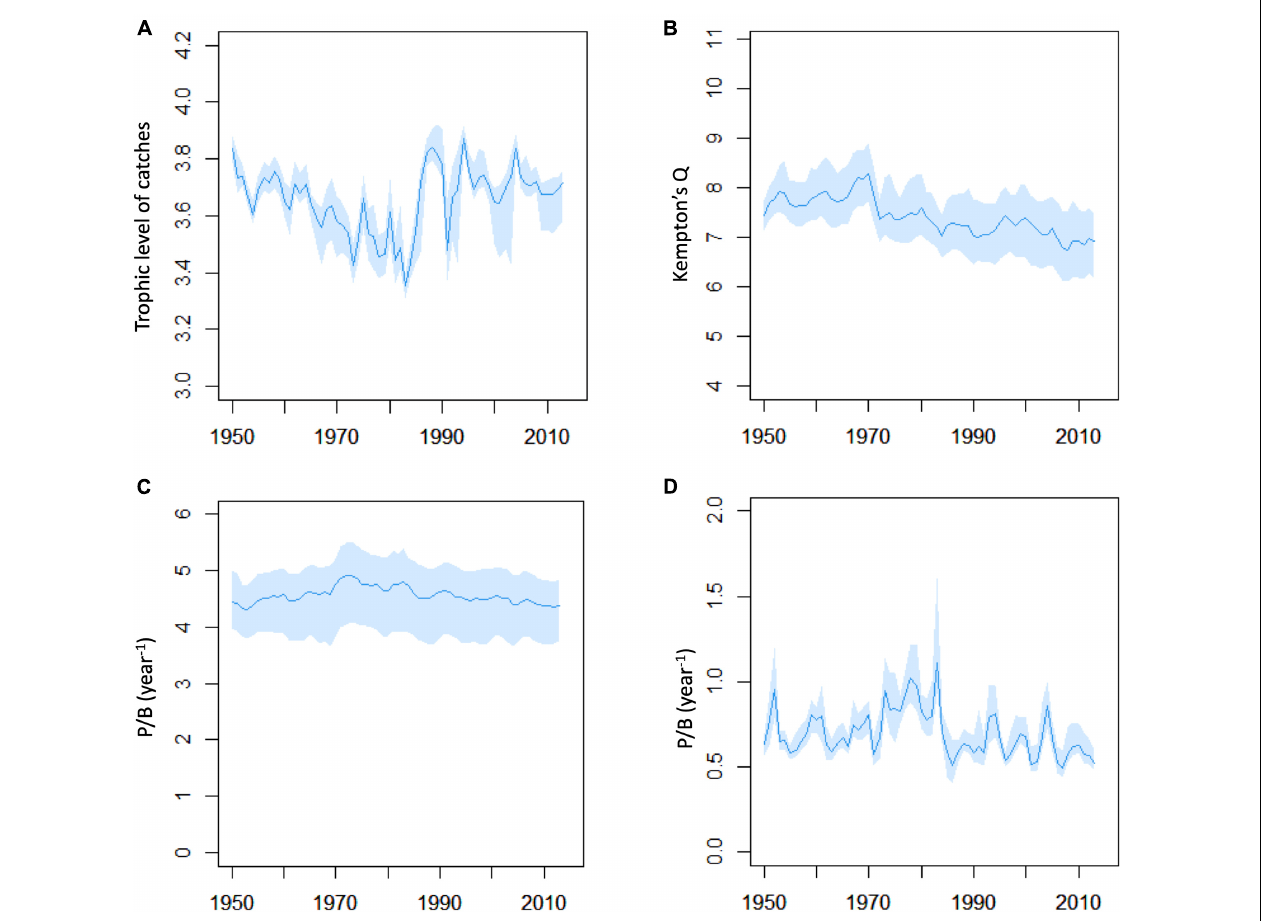
FIGURE 6 | Overview of changes in ecosystem indicators from Ecosim model M10 with Monte Carlo simulations. (A) Trophic level of catch, (B) Kempton’s diversity index Q, (C) total system production/biomass ratio of non-primary producer functional groups, (D) production/biomass ratio based on sum of production and sum of biomass of harvested functional groups. Blue line shows mean value and blue bands shows 2.5 and 97.5 percentiles from 200 Monte Carlo